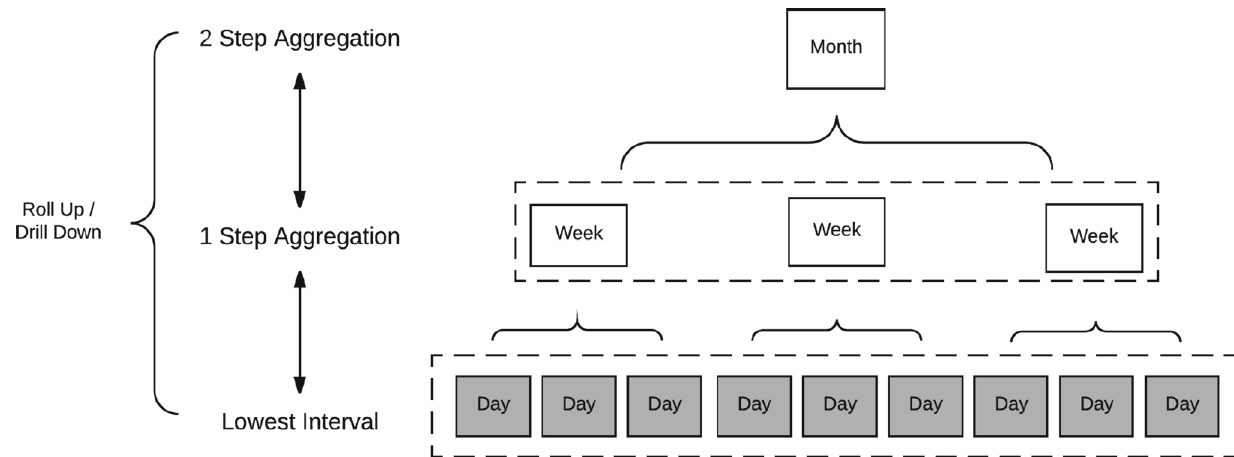
Fig. 3 Time interval index